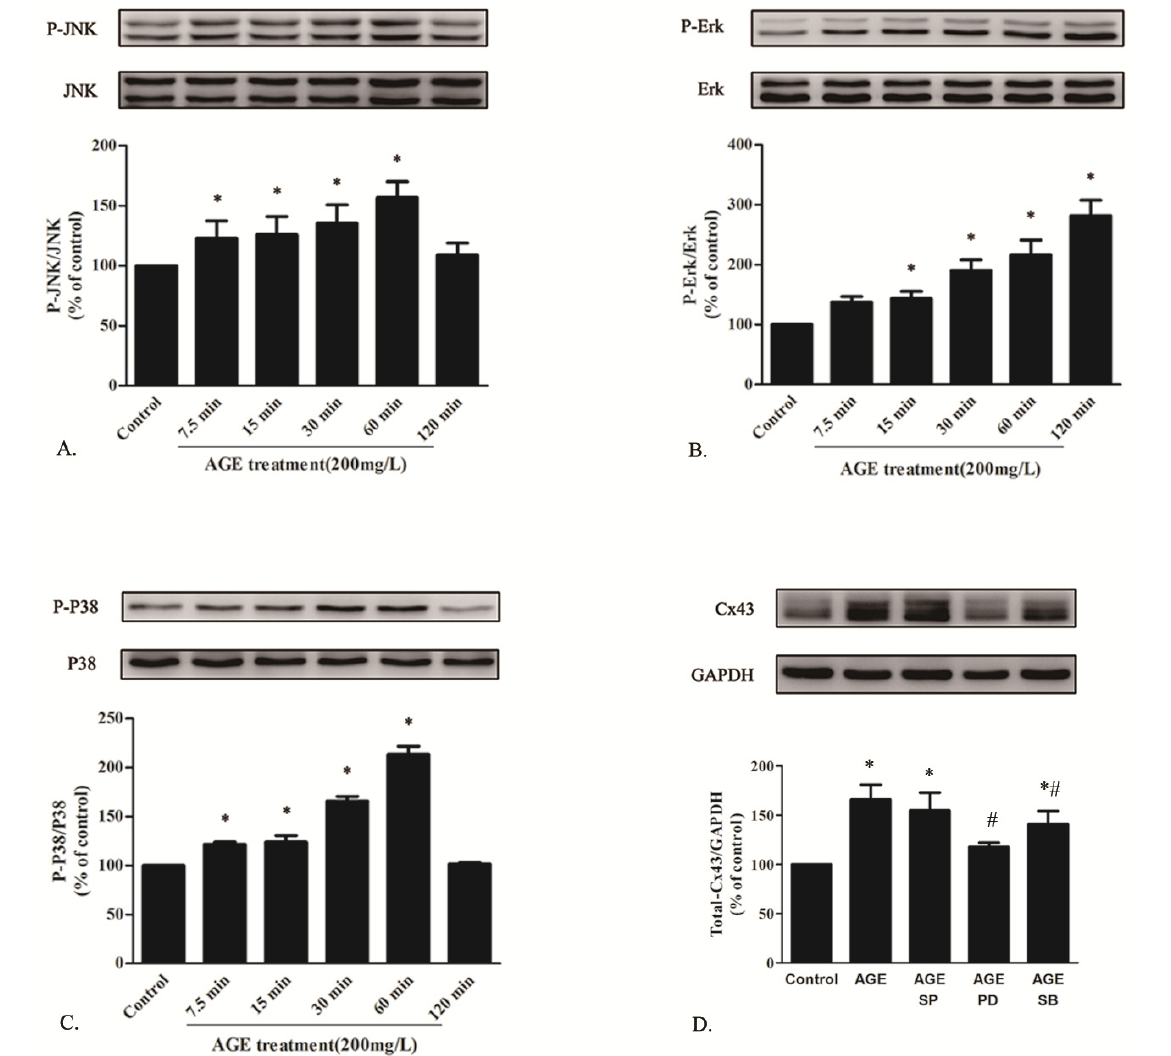
Figure 6. AGE elevated time-dependent phosphorylation levels of JNK ( A ); Erk ( B ) and P38 MAPK ( C ) in cardiomyocytes determined by Western blot. ( D ) Western blot analysis of Cx43 expression in AGE-treated cardiomyocytes with the presence of MAPK